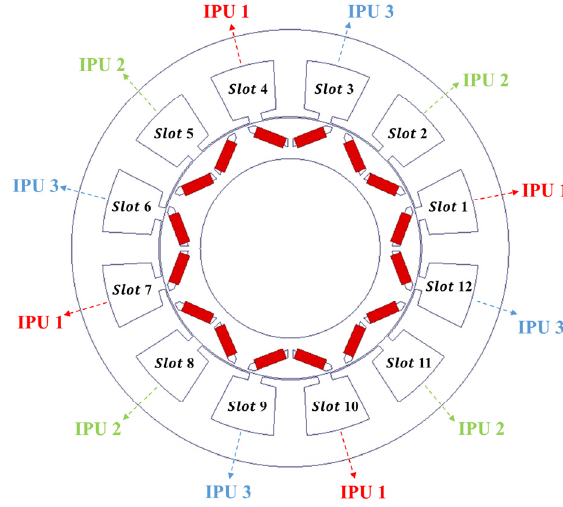
Figure 1. The proposed IPU within an IPM machine.